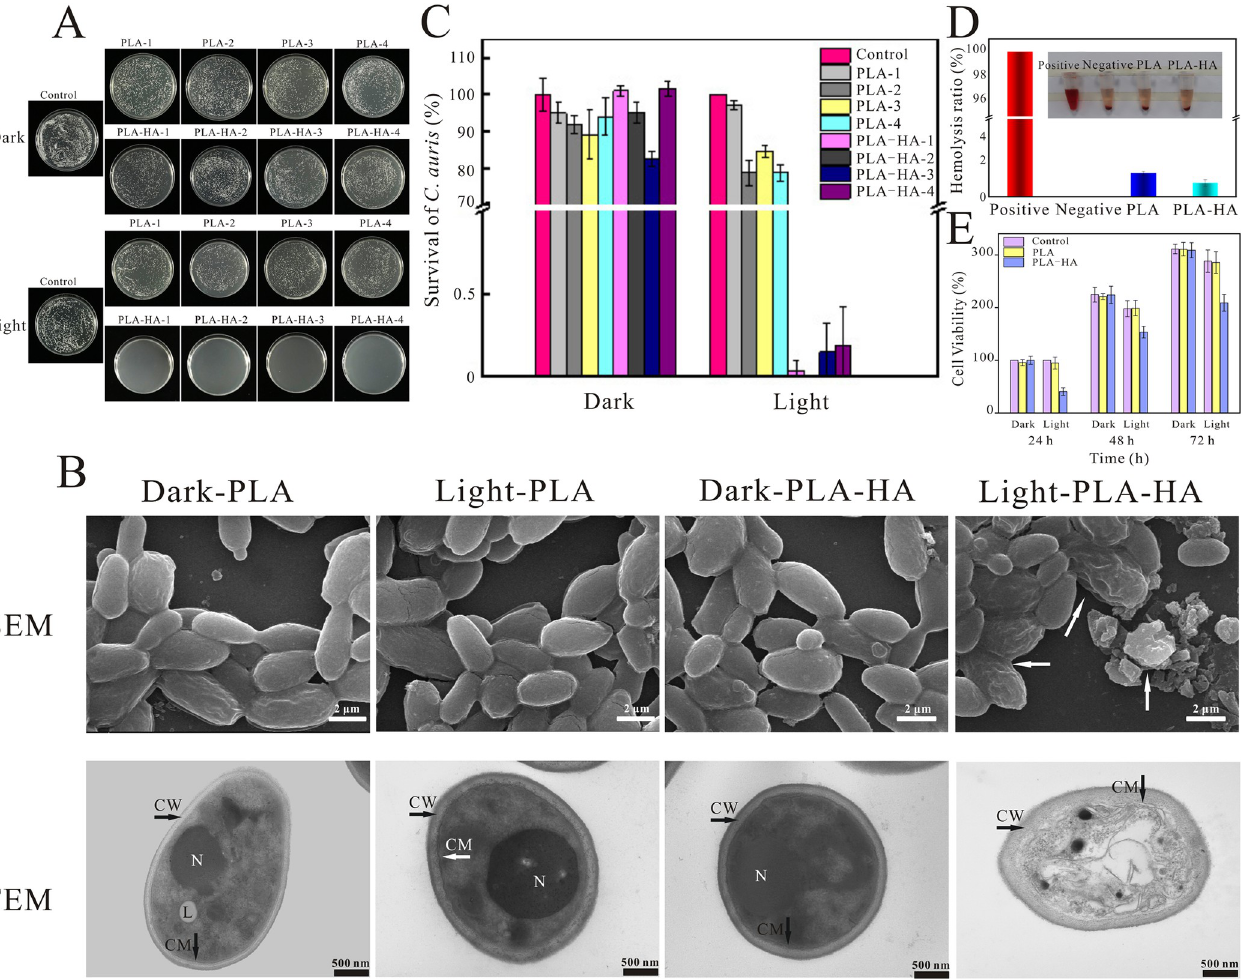
Fig 3. In vitro antifungal activities and biosafety of PLA-HA and PLA. (A) Spread plate results of C . auris growth under different conditions. The images from left to right represent PLA and PLA-HA were repeatedly used for four times. (B) SEM and TEM images of C . auris under different conditions. CM indicates the cytoplasmic membrane, CW represents the cell wall, N indicates the nucleus and L refers to lipid inclusion. (C) Corresponding survival rate results of C . auris with PLA and PLA-HA treatment (n = 3). (D) Hemolysis assay. The inset shows the image directly observed after adding PLA and PLA-HA for 2 h. Distilled water was used as a positive control, and PBS was used as a negative control. (E) Cell toxicity evaluation of PLA and PLA-HA on mouse fibroblast L929 cells for 24 h, 48 h and 72 h. Data are presented as the mean ± s.d.